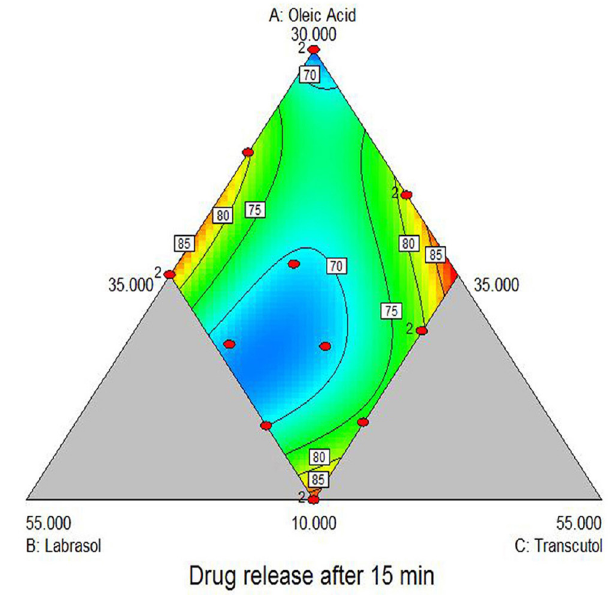
FIGURE 6- Response surface plot of drug released after 15 min (Y ) versus three factors (X 3 Transcutol